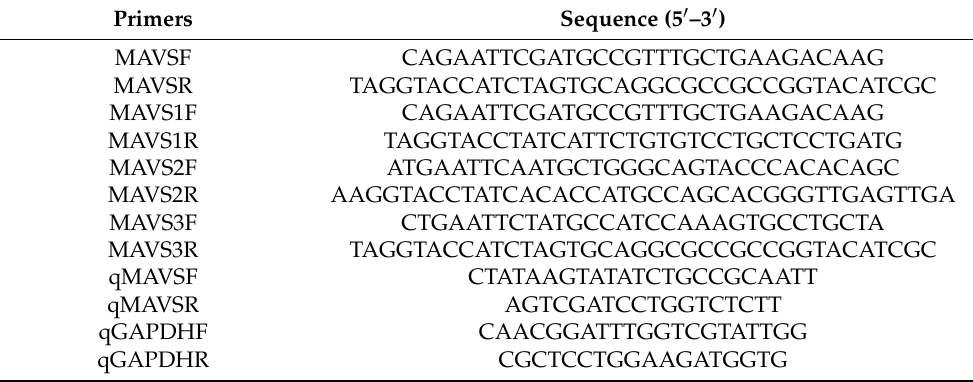
Table 1. Primers and corresponding sequences.